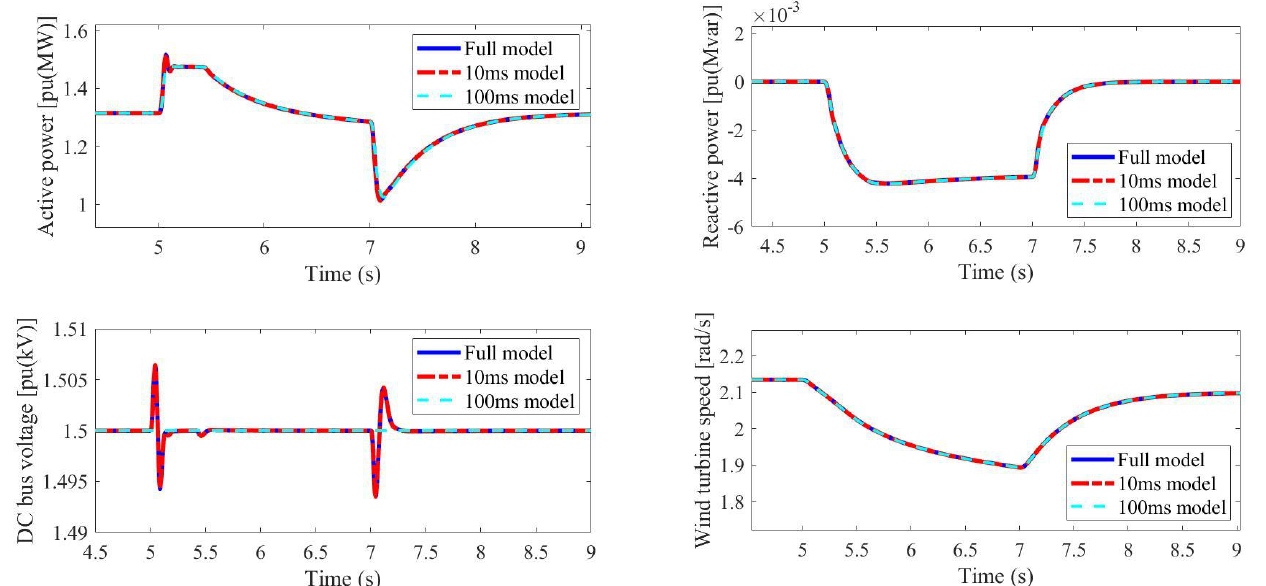
Figure 8. Grid frequency disturbance: timescale model